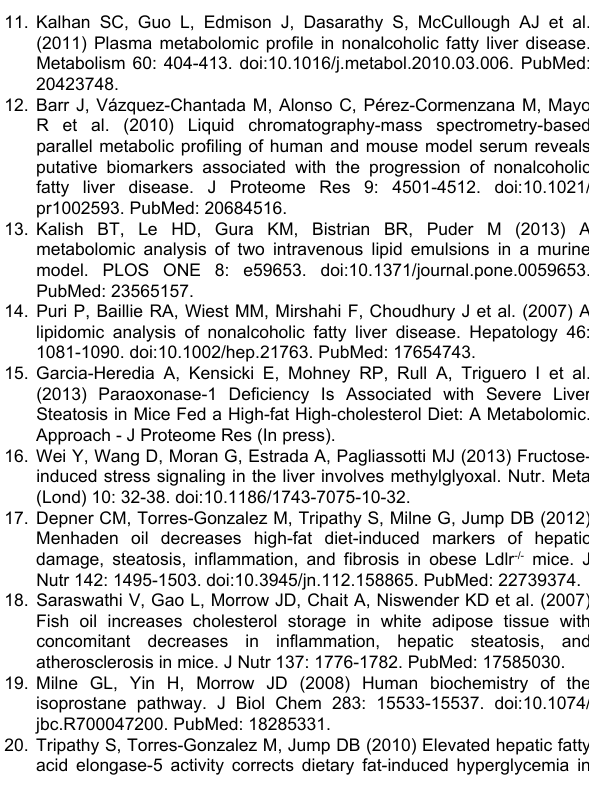
Table S3. Volcano plot data comparing WD + O versus WD + D fed mice. Volcano plots were prepared as described in Methods using software at (http://www.metaboanalyst.ca). This table represents the data used to construct Figure 3B. Table S4. Correlation of oxidized fatty acids with precursor fatty acids. Metabolites used to carry out a correlation analysis were quantified by the metabolomic analysis